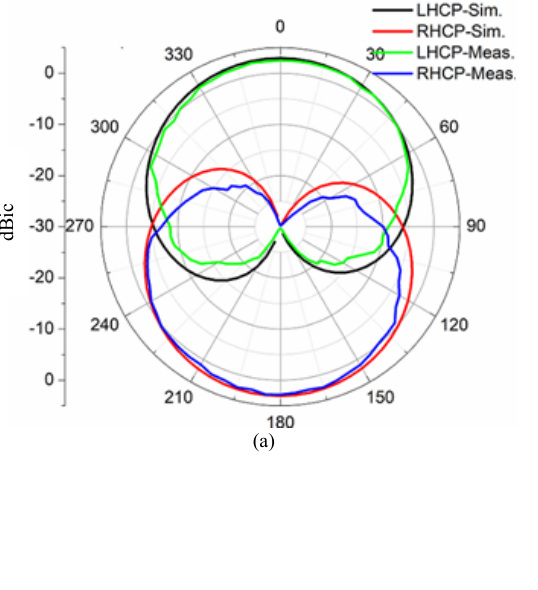
Fig. 19. Simulated and measured radiation patterns at 5.2 GHz for xz - and yz -plane.